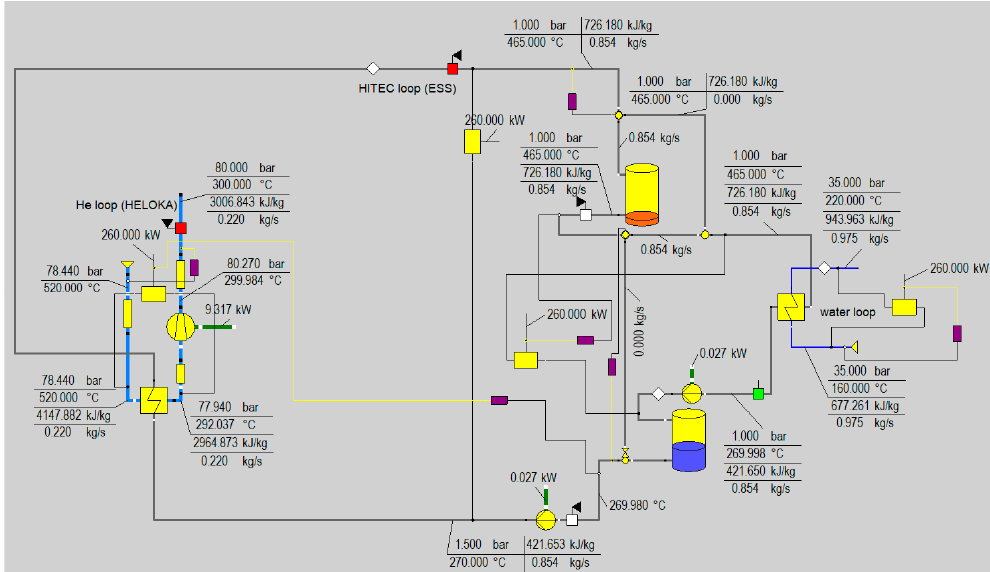
Figure 11. EBSILON simulation of HELOKA–US pulse operation.